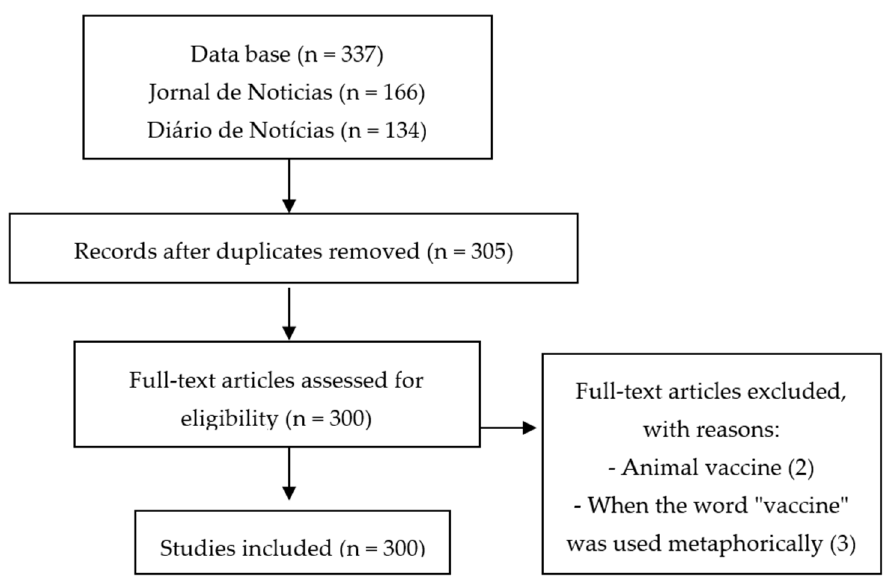
Figure 1. Search strategy and synthesis of the process of obtaining the selected articles.